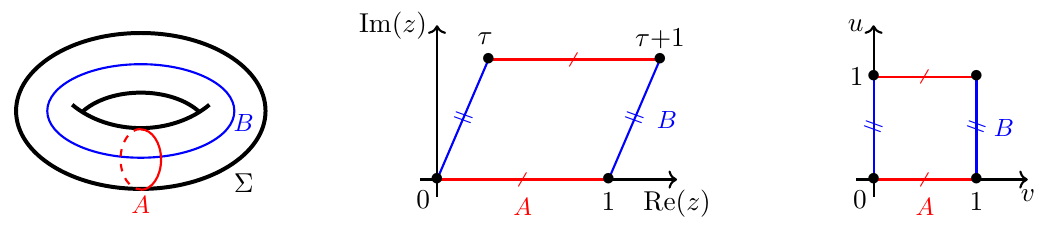
Figure 1 . The torus Σ = C / Λ with a choice of canonical homology cycles A and B (left figure), is represented in the plane by a parallelogram with complex coordinates z, ¯ z (middle figure) or a square with real coordinates 0 ≤ u, v ≤ 1 (right figure) related by z = uτ + v , and opposite sides pairwise